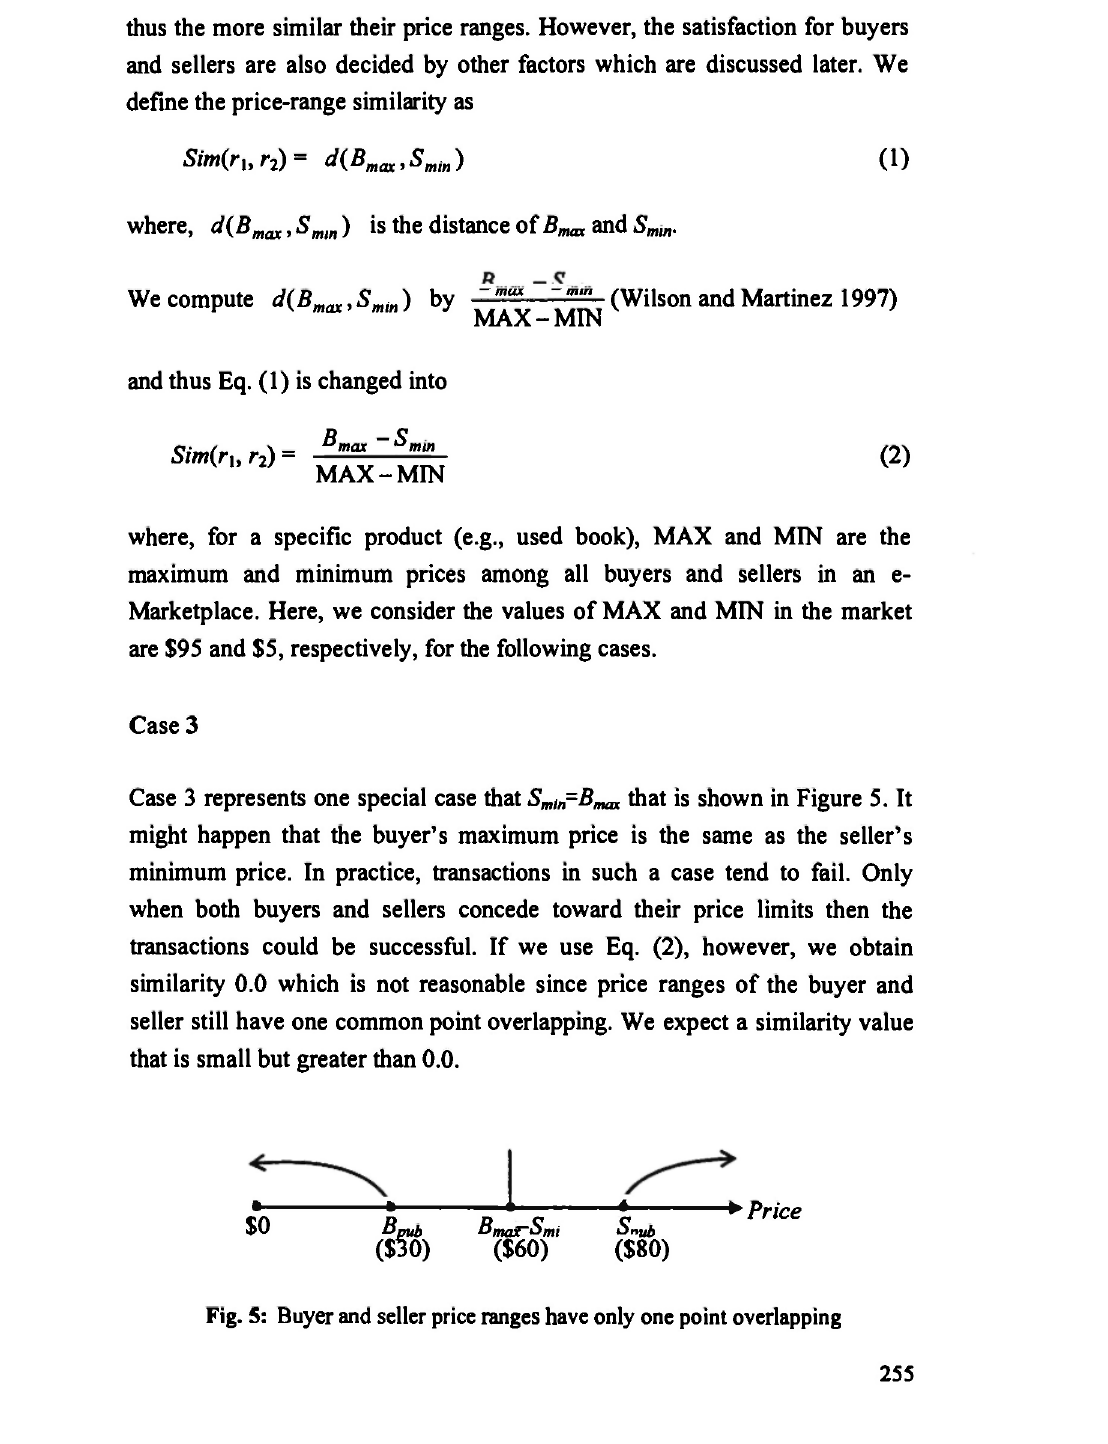
Fig. 5: Buyer and seller price ranges have only one point